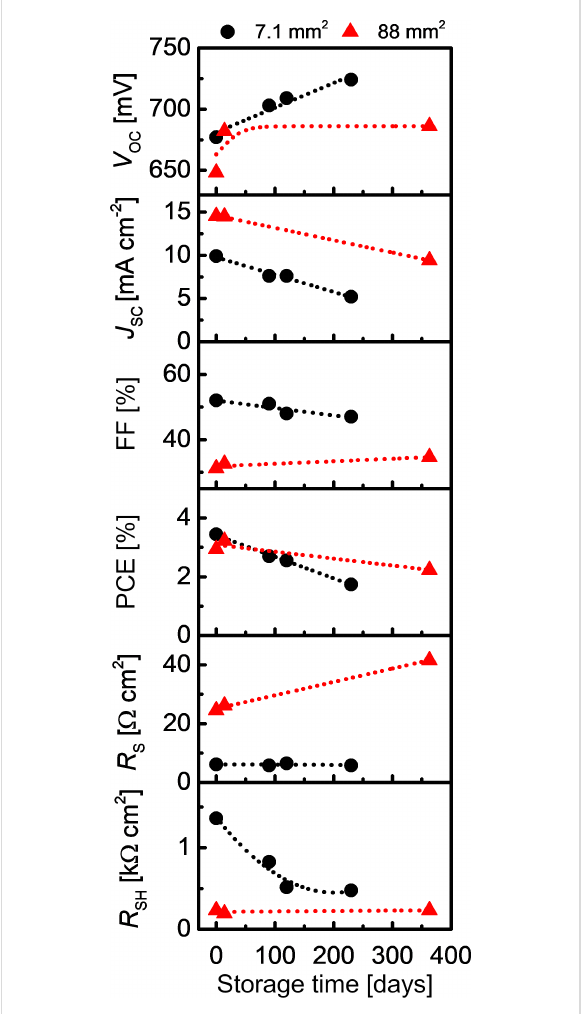
Figure 6: Photoconversion parameters of ( ≈ 100 nm Sb 2 S 3 ) solar cells at AM1.5G as a function of storage time. The dotted lines are a guide to the eye. Black circles refer to 7.1 mm 2 cell area, and red triangles refer to 88 mm 2 cell area. Samples composed of several small cells with P3HT only partially covered by Au were kept without any particu- lar artificial conditions or encapsulation, and between measurements, were exposed to air and cycles of both indoor fluorescent tube irradia- tion and daylight for up to 363 days at ≈ 20 °C, RH